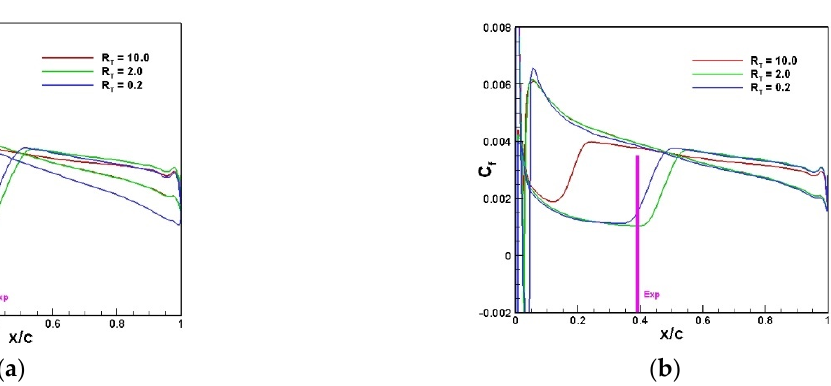
Figure 9. γ -Re θ t -CF SST transition model with different sustaining turbulence terms. ( a ) Sustaining turbulence approach in [4]. ( b ) Present approach.